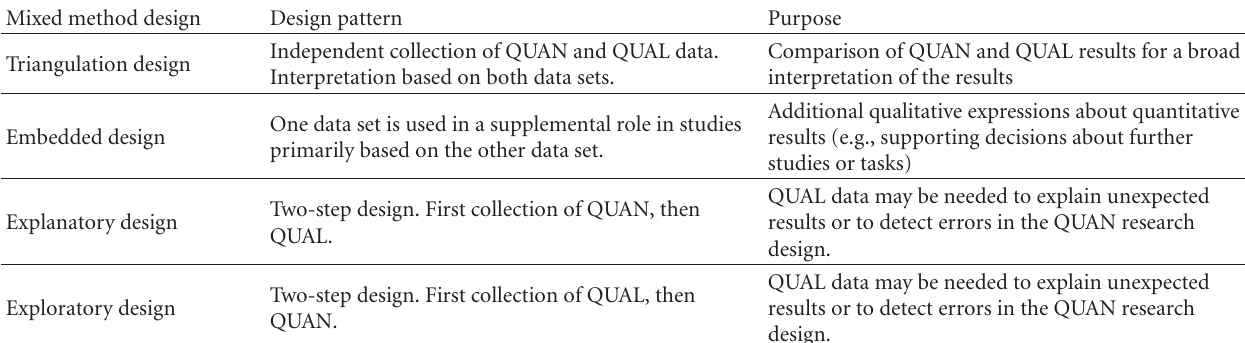
Table 2: Mixed method designs according to Creswell and Plano Clark